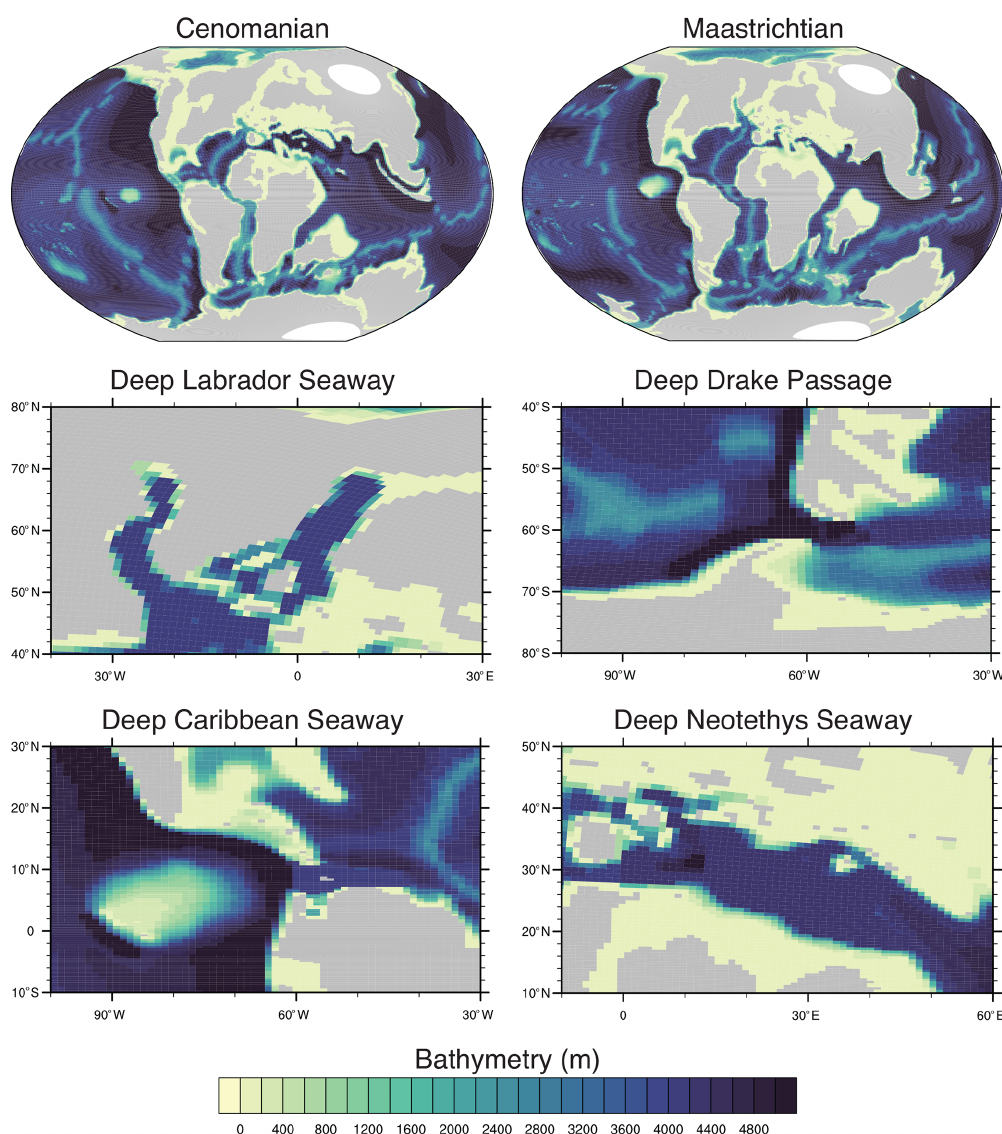
Figure 1. Bathymetry of the Cenomanian and Maastrichtian configurations and enlargements of regions where bathymetric changes were made in the gateway sensitivity